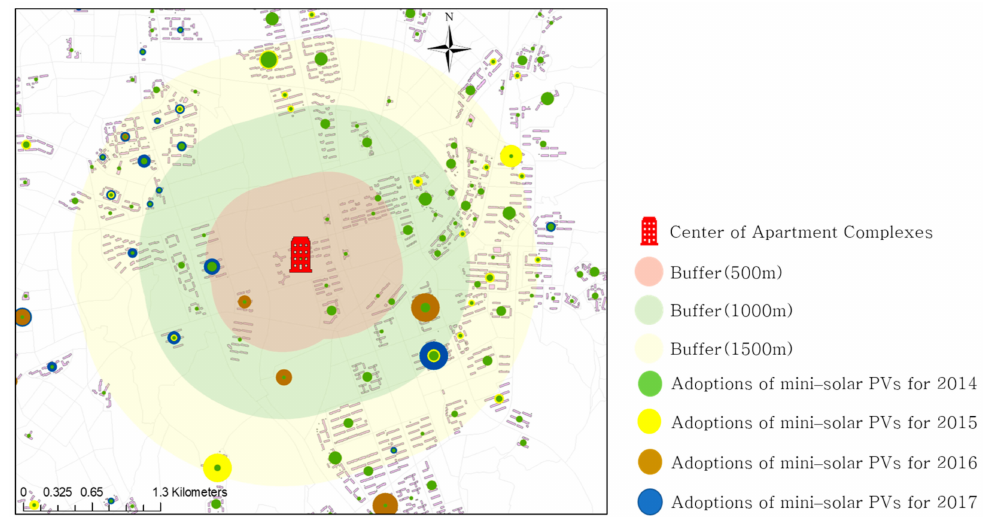
Figure 5. Extraction of the number of households within